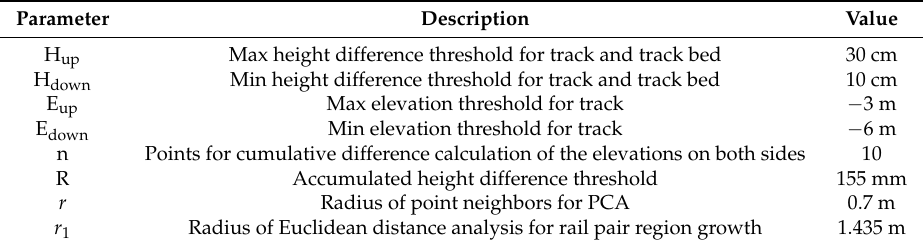
Table 4. Parameters used in the proposed method for fast rail extraction.